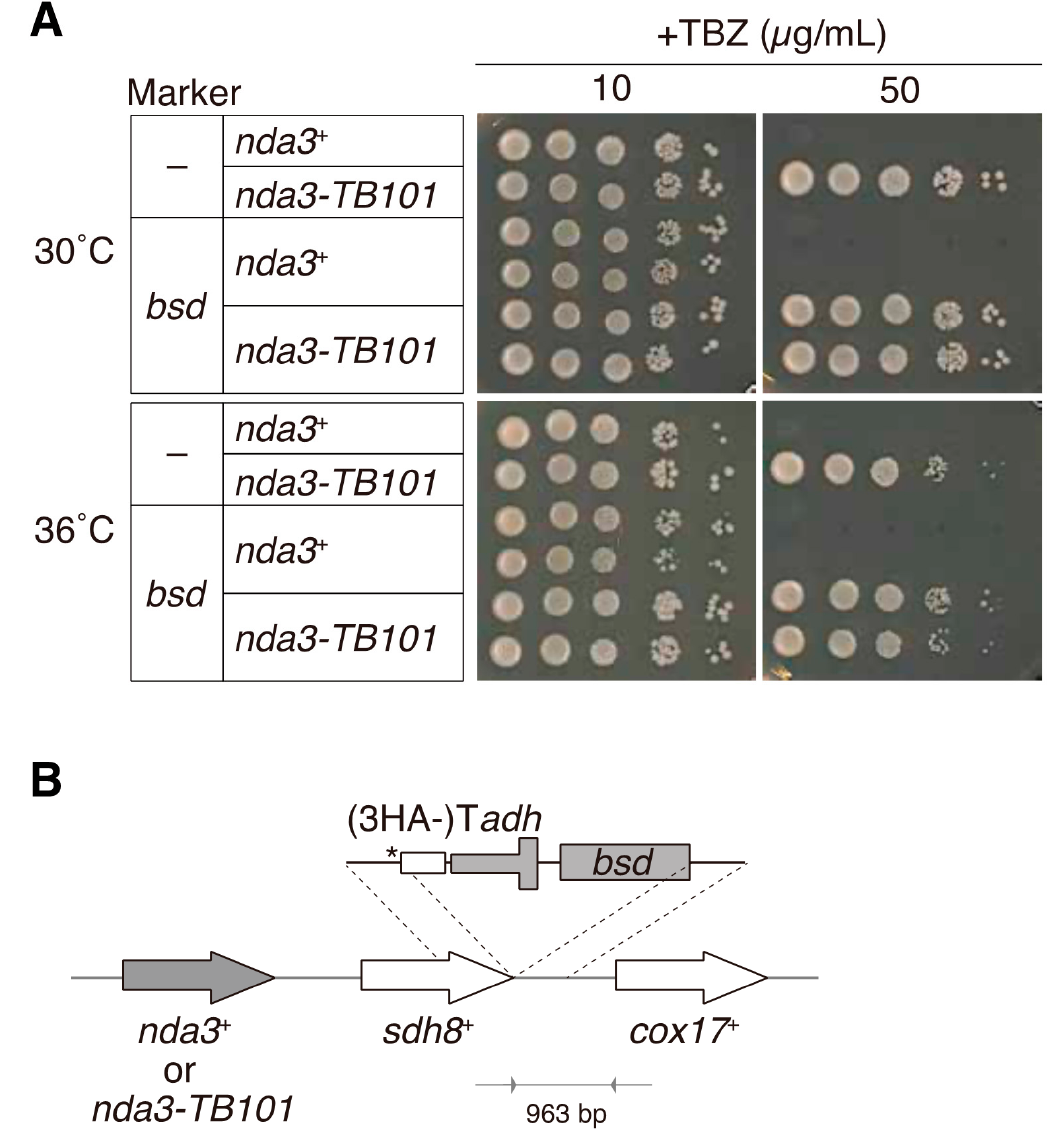
Figure 1. The β -tubulin mutant nda3-TB101 is resistant to TBZ. ( A ) The indicated strains were tested for TBZ resistance to TBZ. The nda3 + has the WT nda3 gene. The column “marker” indicates whether the blasticidin S resistance gene ( bsd ) was inserted near the nda3 locus as illustrated in B, not inserted (–). Ten-fold serial dilutions of cells with indicated genotypes were spotted on the rich medium containing TBZ (10 or 50 µ g/mL) and the plates were incubated at 30 ◦ C or 36 ◦ C. ( B ) A schematic illustrating the construct of marker insertion into a chromosome. The bsd gene was inserted at the downstream of the sdh8 + gene, which located next to the nda3 + (or nda3-TB101 ) gene. To guarantee the expression of the sdh8 + gene, the adh1 terminator (Tadh) was inserted followed by bsd . The DNA sequence encoding three copies of HA (3HA) was also inserted at the 3’ end of sdh8 + , but the termination codon (asterisk) was placed to avoid fusion of Sdh8 protein with